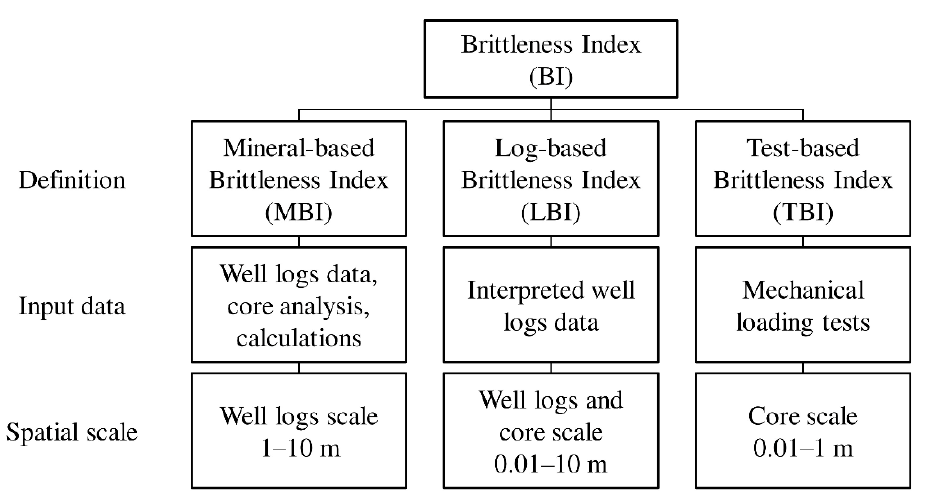
Figure 1. Classification of brittleness